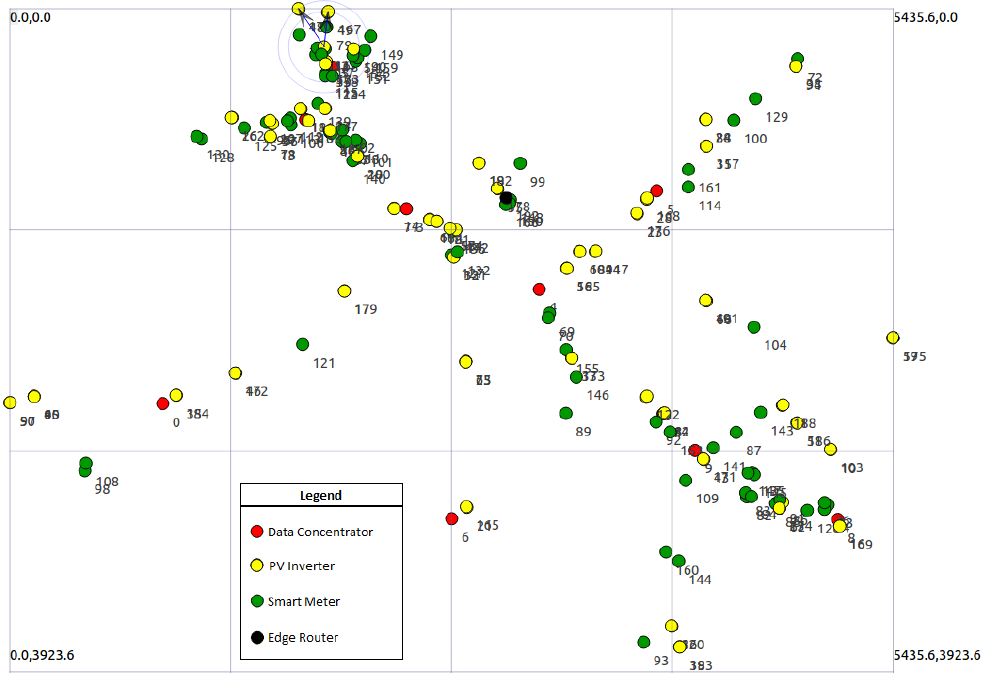
Figure 3. Screenshot of LoWPAN-WiFi network animation on top of